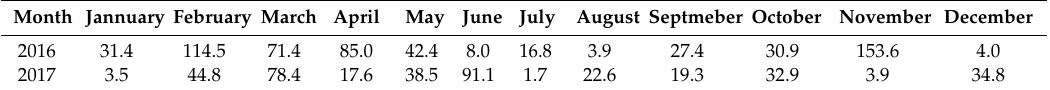
Table 1. Rainfall (in mm) in Huesca in 2016 and 2017.